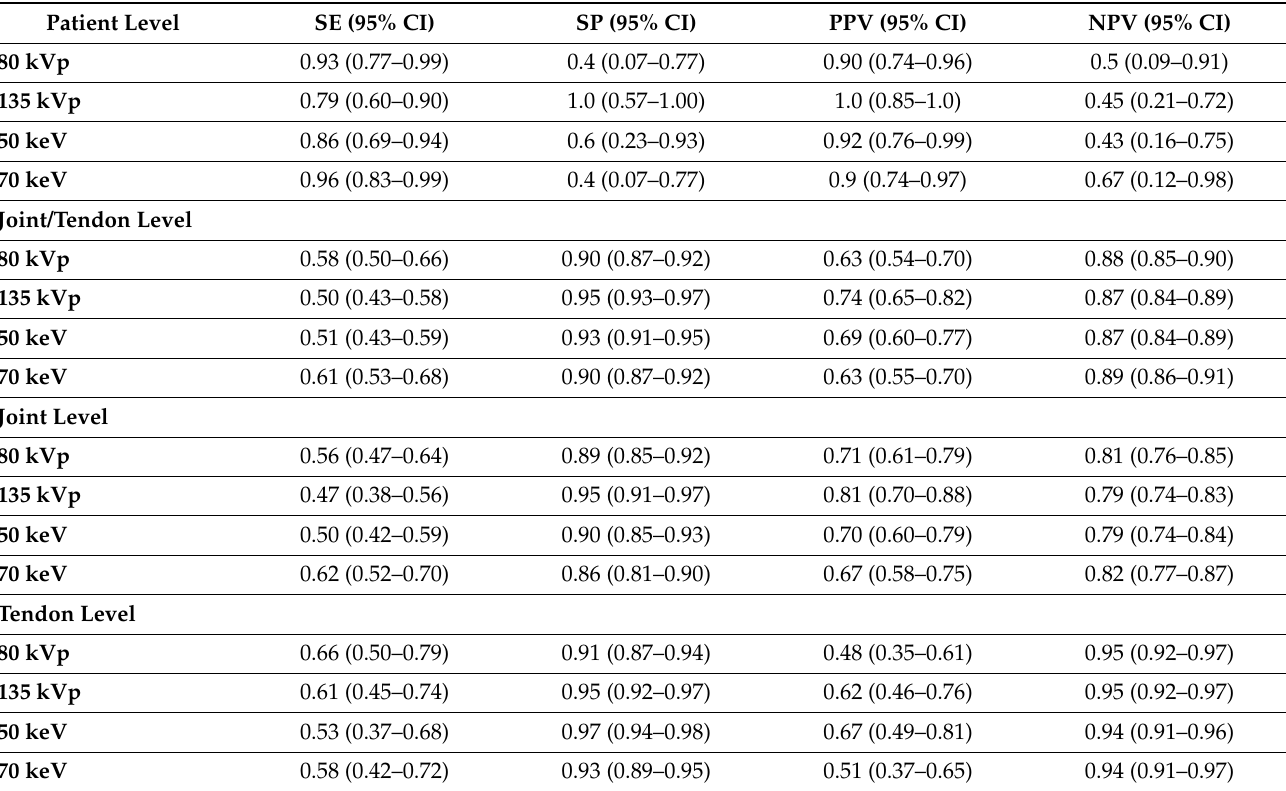
Table 2. Results of the contingency table analysis. SE = sensitivity, SP = specificity, PPV = positive predictive value, NPV = negative predictive value, 95% CI = 95% confidence interval of the